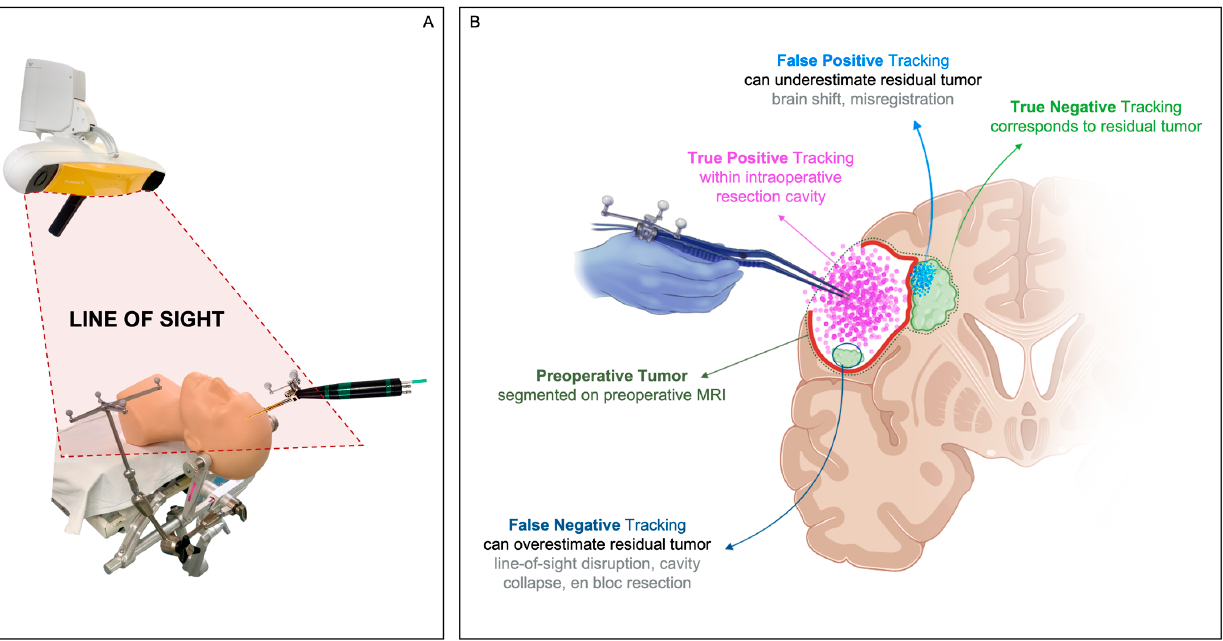
Figure 1. Panel A —Line-of-sight. Panel B —True Positive Tracking should ideally correspond to the intraoperative resection cavity estimated on iMRI. False Positive Tracking due to brain shift or misregistration can underestimate residual tumor. False Negative Tracking due to line-of-sight disruption, cavity collapse, en bloc resection can overestimate residual tumor. True Negative Tracking should ideally correspond to the residual tumor estimated on